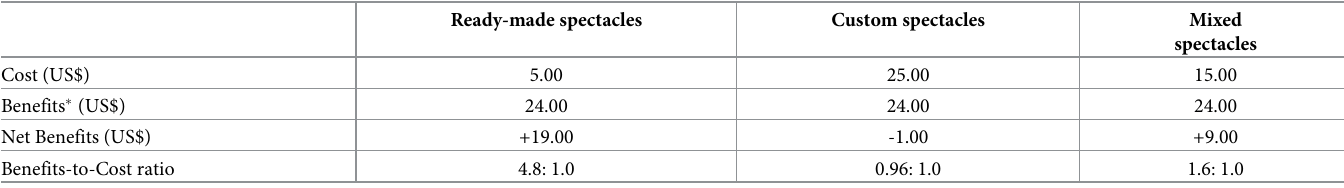
Table 2. Net benefits